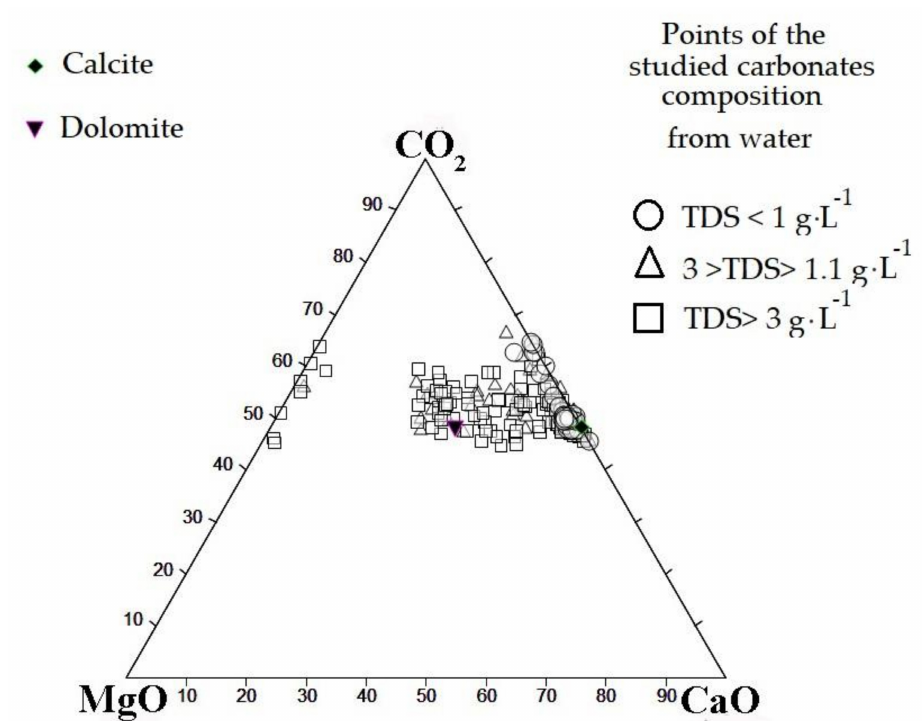
Figure 6. Ferre Triangle of calcite–dolomite series’ carbonate (%-eq) composition formed in small lakes in the south of Western Siberia taking into account the value of TDS (g · L − 1 ). The composition of calcite (rhombus) and dolomite (inverted triangle) corresponds to the theoretical formula.